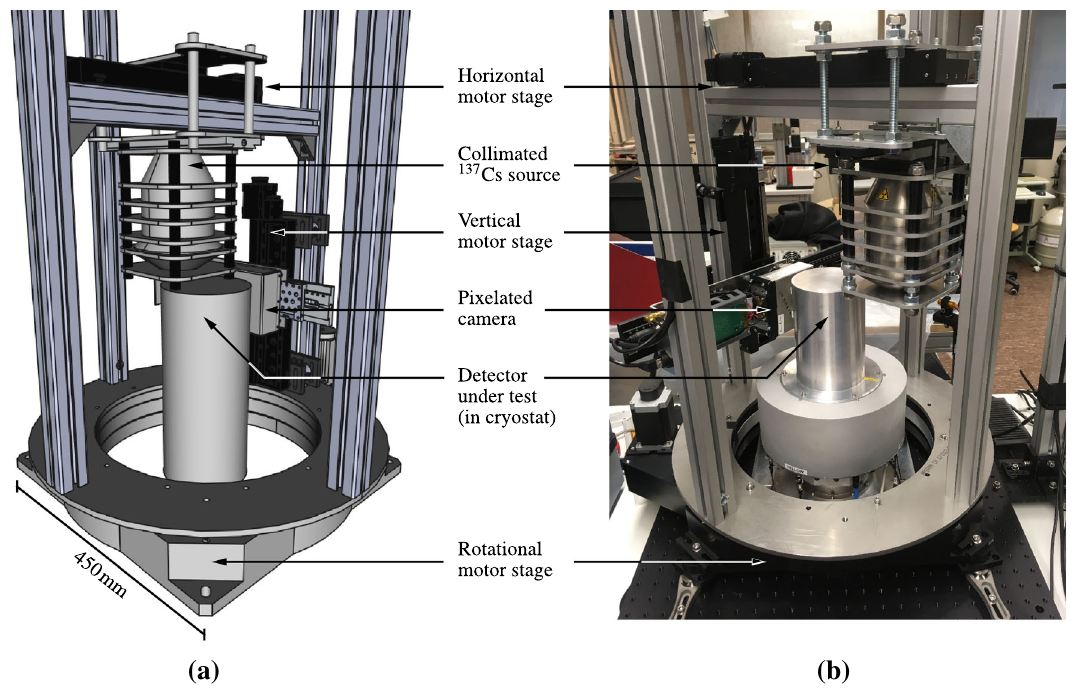
Fig. 2 a 3D model and b photo of the Compton Scanner setup. The vertical motor is used to place the pixelated camera at an optimal height with respect to the detector under test. The horizontal motor allows to move the 137 Cs source along the line which connects the centers of